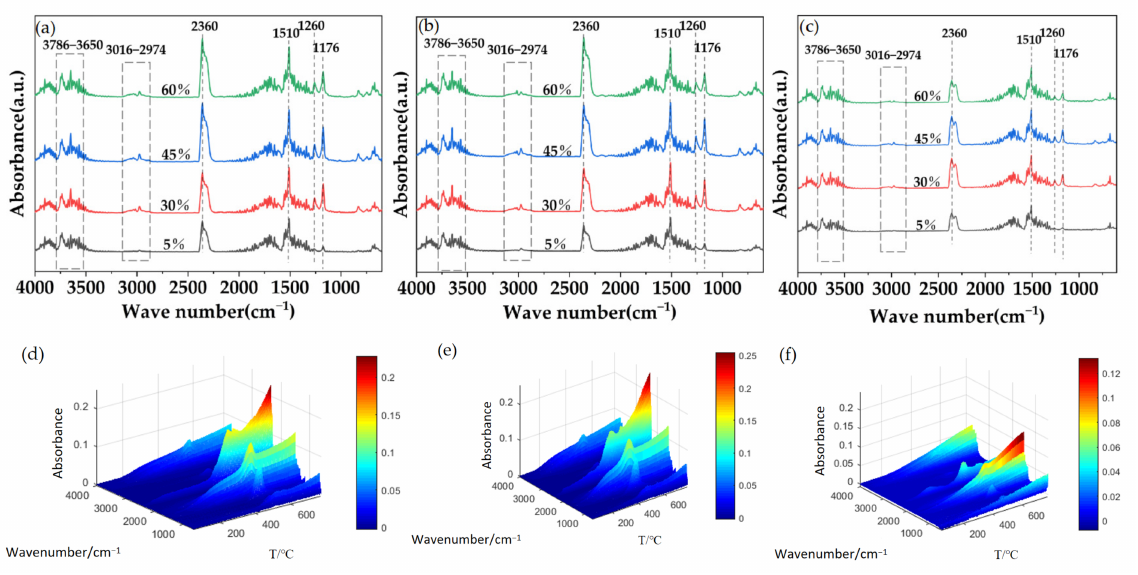
Figure 15. Infrared spectra of ( a ) PC, ( b ) PC-f and ( c ) PC/GF15-f gas phase cleavage products, 3D IR spectra of ( d ) PC, ( e ) PC-f and ( f ) PC/GF15-f gas phase cleavage